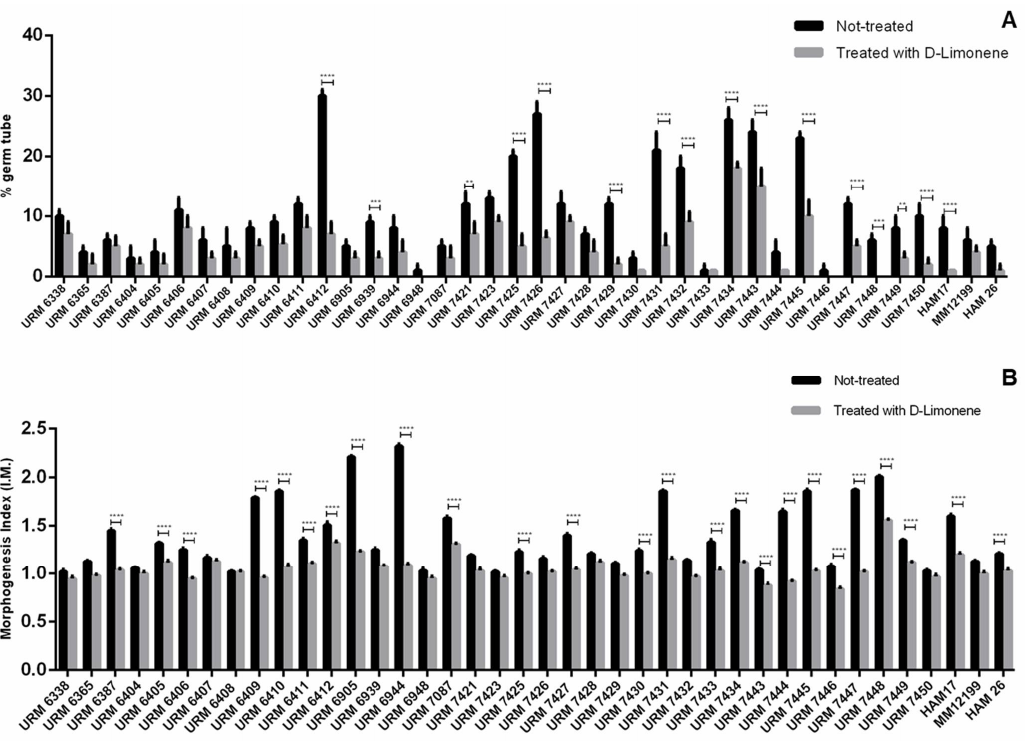
Figure 1. Evaluation of yeasts morphogenesis inhibition of Candida parapsilosis complex by D- limonene: ( A ) Germ tube emission after 1 h of incubation; ( B ) morphogenesis index (IM) after 3 h of incubation. Data represent mean and standard deviation in triplicate ( n = 3). For the analysis, a Tukey′s multiple comparison test was performed for all means obtained at a significance level of 5%. The symbols “**”, “***”, “****” indicate significant differences between germ tube emission percentage and morphogenesis index ( p ≤ 0.001), ( p ≤ 0.0003), and ( p ≤ 0.0001), respectively.